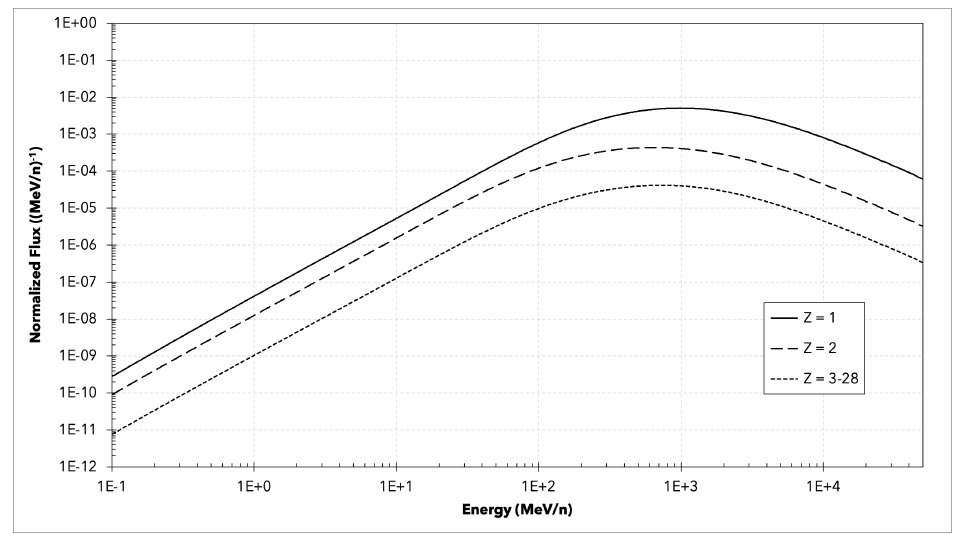
Figure 2. The energy spectra of the source term used in this work obtained from [17] for solar modulation of 400 MV. All ions were run collectively in PHITS, while each ion was run separately in HETC-HEDS. The division of GCR ions into three categories in this plot is for demonstration purposes. Table 1. The components of the CRaTER instrument starting from S1 facing the zenith (deep space) and S2 facing the nadir (lunar surface). A schematic of the CRaTER instrument is provided in [1]. Component Material Thickness